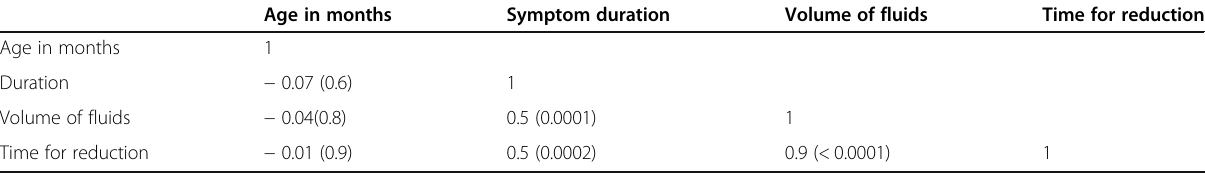
Table 3 Correlation among age in months, duration, volume of fluid, and time for